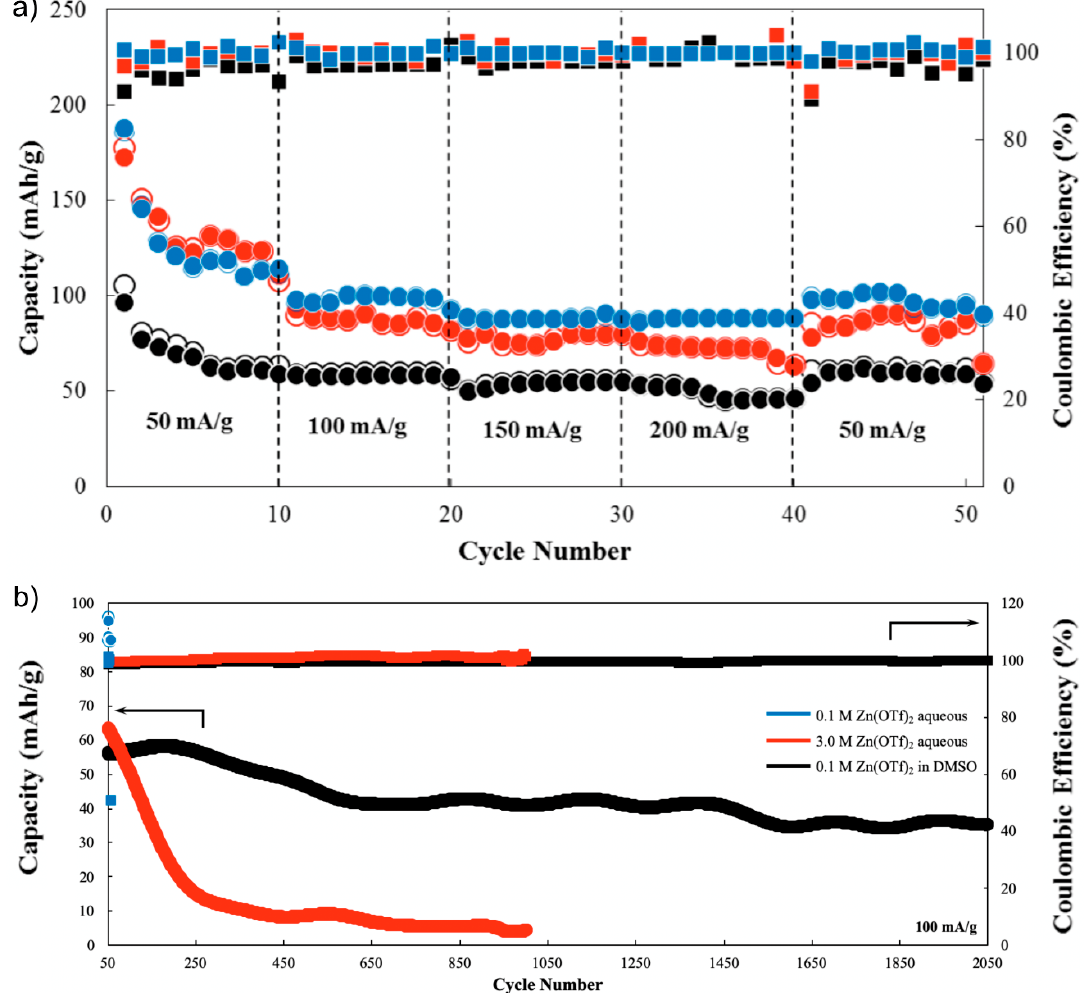
Figure 4. ( a ) Rate capability test of α -MnO 2 -carbon fiber composite at different current densities of 50, 100, 150, and 200 mA·g − 1 and the corresponding voltage-charge profile with voltage window of 0.4 to